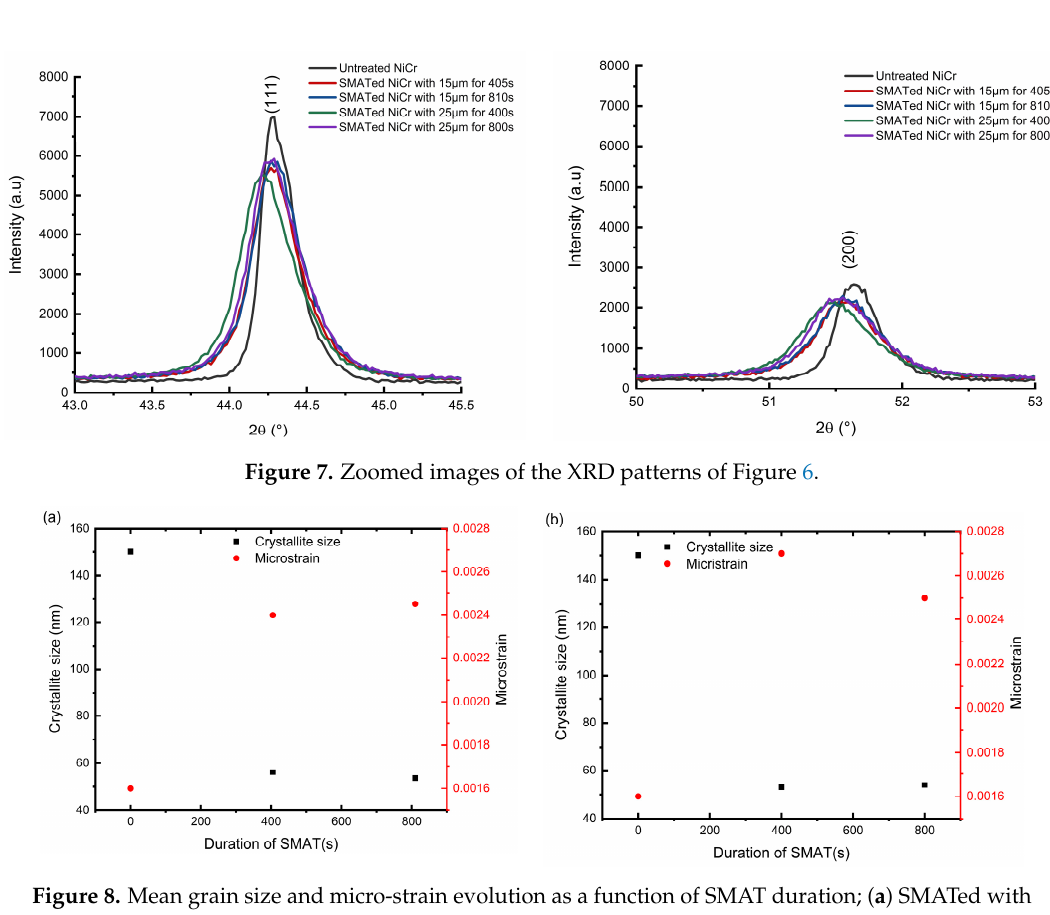
Figure 8. Mean grain size and micro-strain evolution as a function of SMAT duration; ( a ) SMATed with an amplitude of 15 µm; ( b ) SMATed with an amplitude of 25 µm.